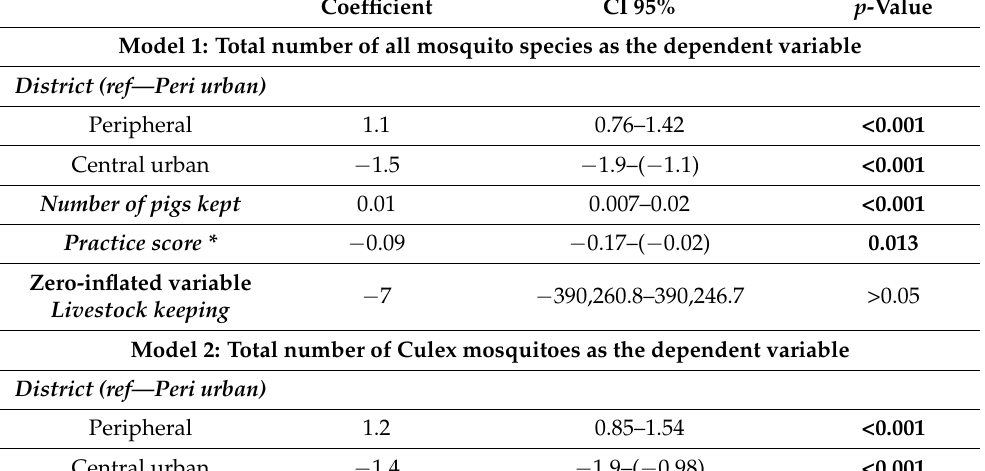
Table 8. Factors associated with the quantity of mosquitoes using a zero-inflated negative binomial regression model with the Vuong test.